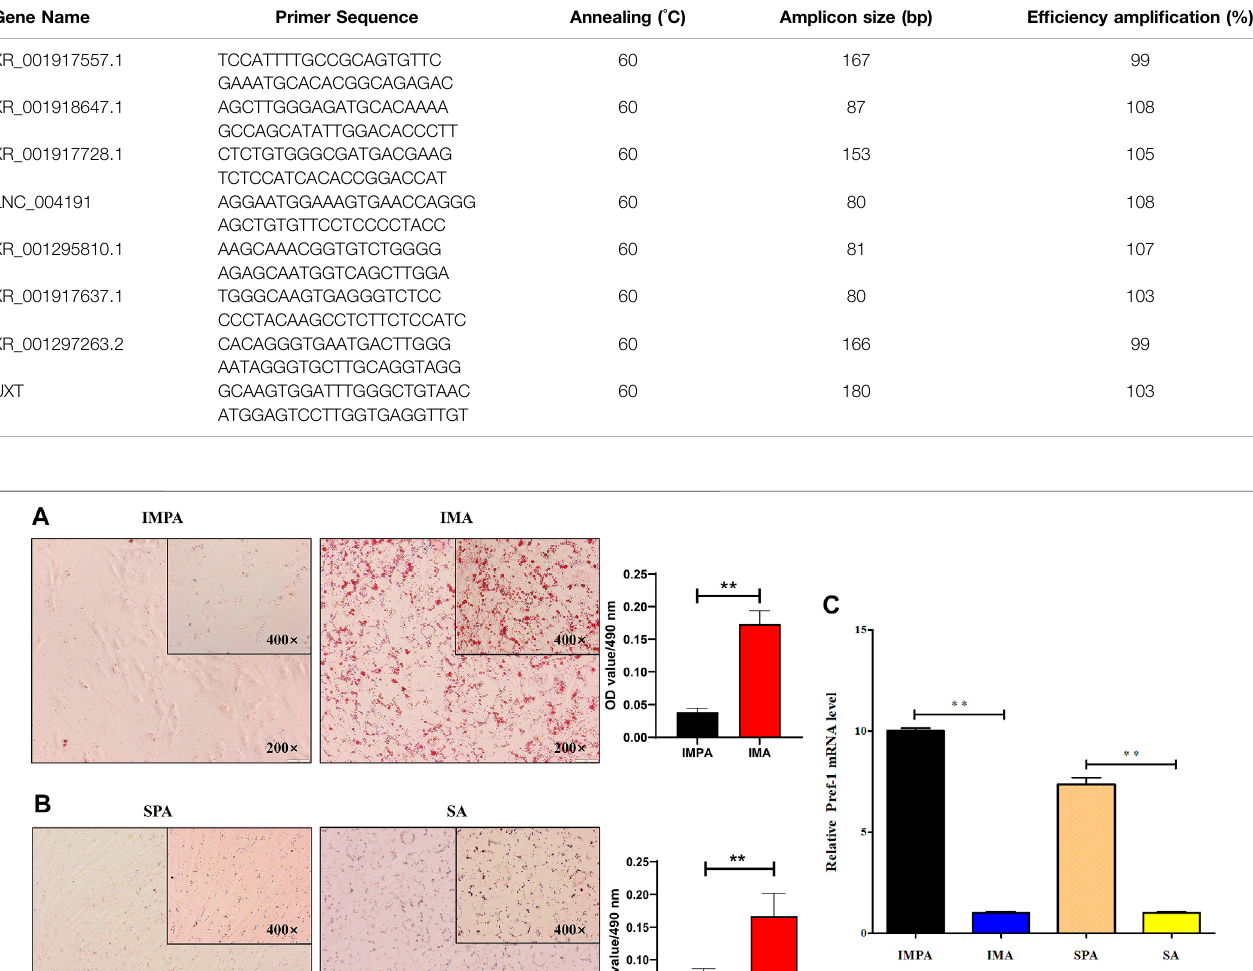
TABLE 1 | Primer sequences of lncRNA ampli fi ed by qRT-PCR.